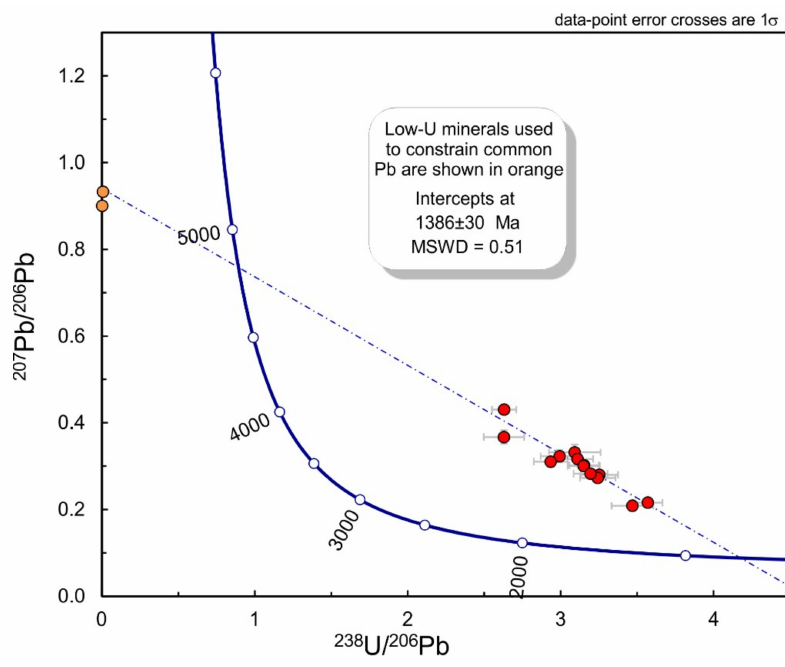
Figure 3. Tera-Wasserburg concordia diagram for the dated apatite